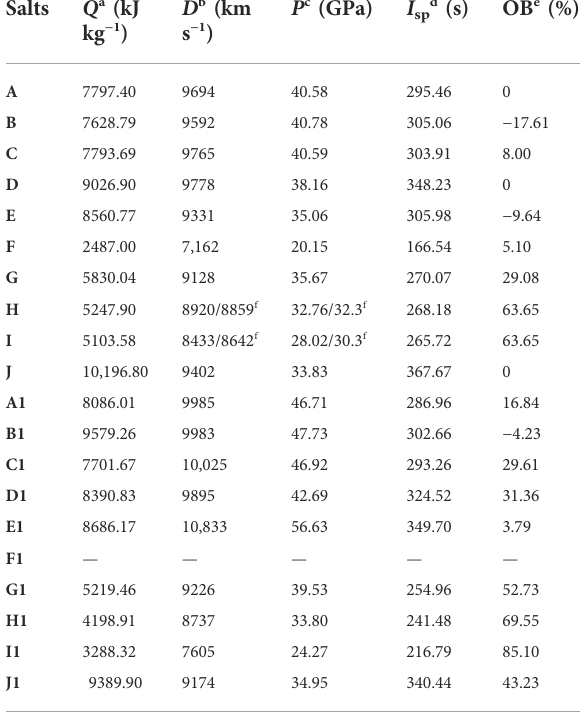
TABLE 3 Predicted explosive properties, speci fi c impulse (Isp) and oxygen balance of N 5 + and O 2 + salts.